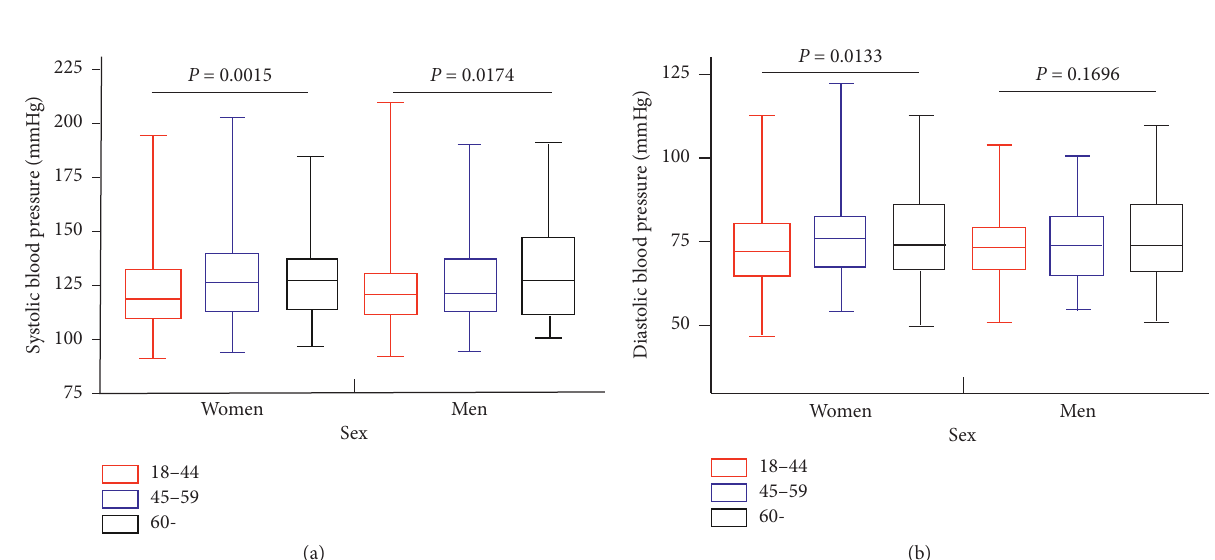
Figure 1: Level of blood pressure by age and sex (a) for systolic blood pressure and (b) for diastolic blood